Question: Which visualization type does this figure use?
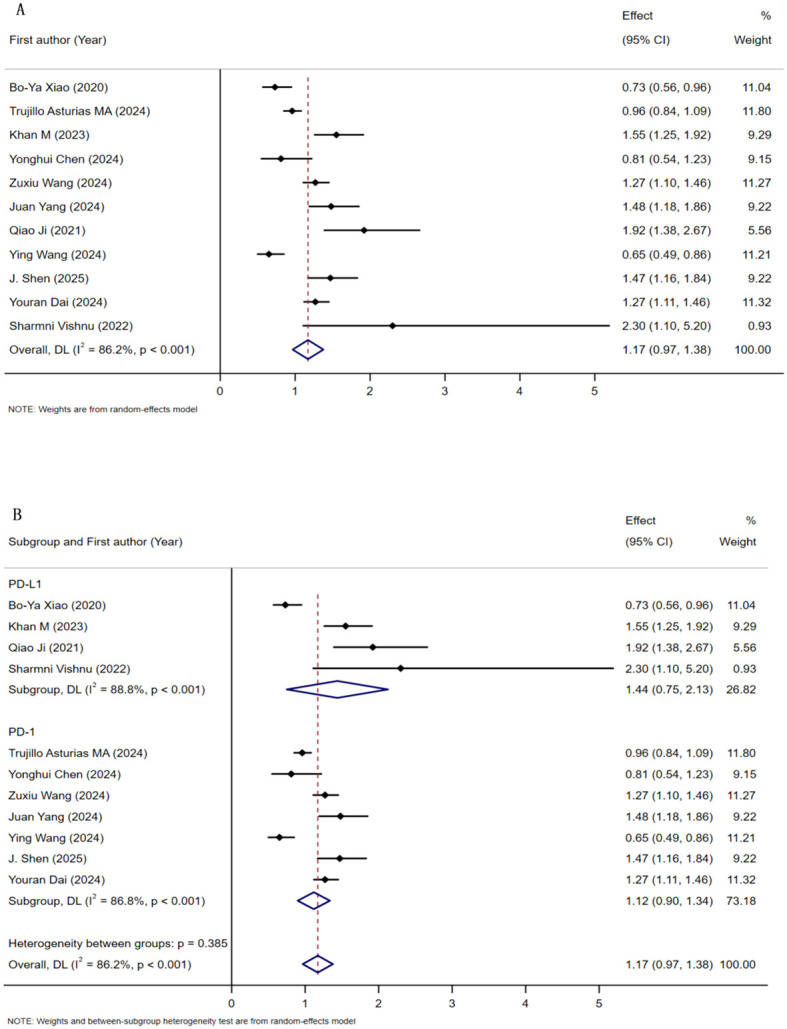
Answer: forest